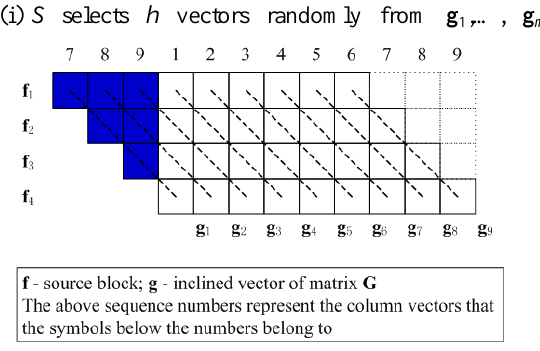
Fig. 2. Inclined vectors of matrix G ( n =4 and m =9).